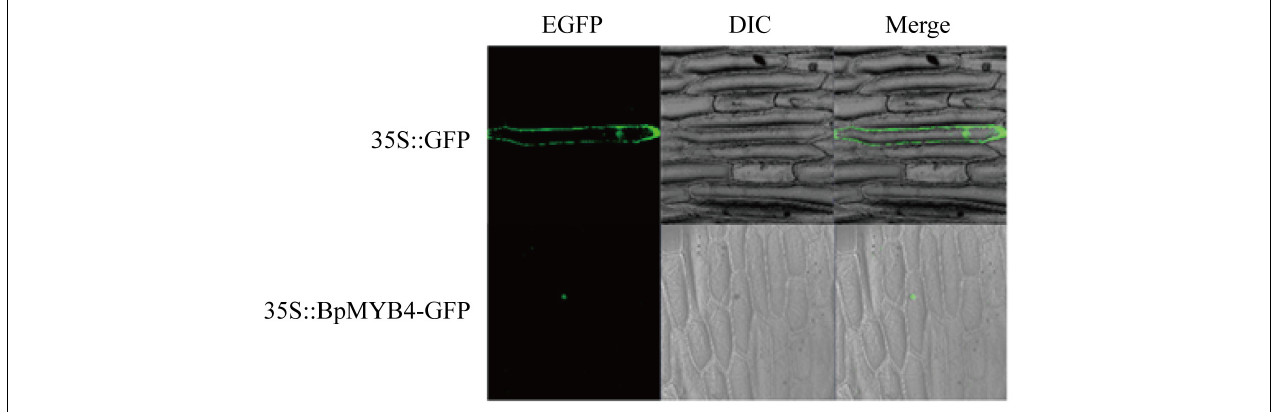
FIGURE 2 | Sub-cellular localization of BpMYB4 protein in onion epidermal cells. Onion epidermal cells were transiently transformed with constructs containing vector 35S: BpMYB4-GFP through particle bombardment method. Sub-cellular localization of 35S: BpMYB4-GFP fusion proteins were viewed using fluorescent confocal